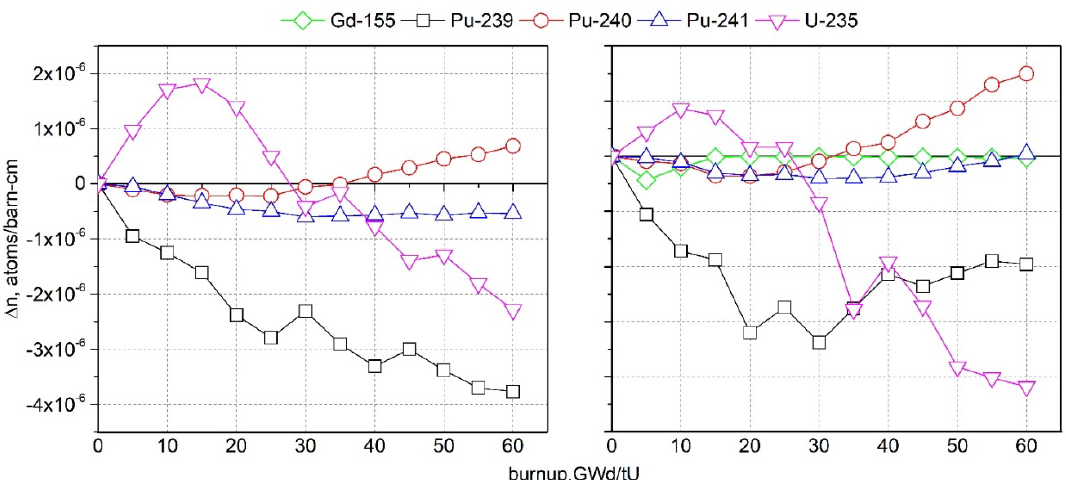
Figure 8. Difference in number densities for several nuclides obtained with the WIMS-10A and SCALE-6.2 codes for the BWR pin-cell ( left ) and BWR 3 by 3 array ( right ) models.